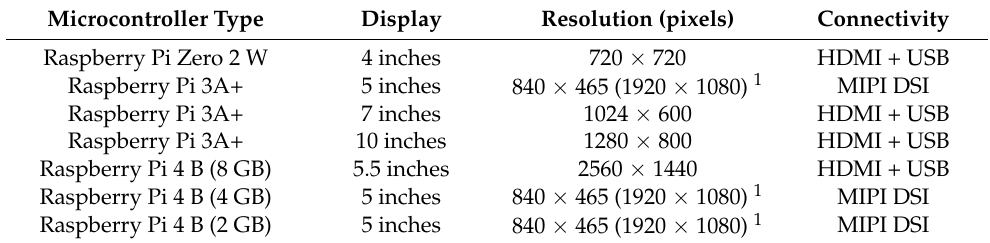
Table 2. List of microcontrollers and display configuration.